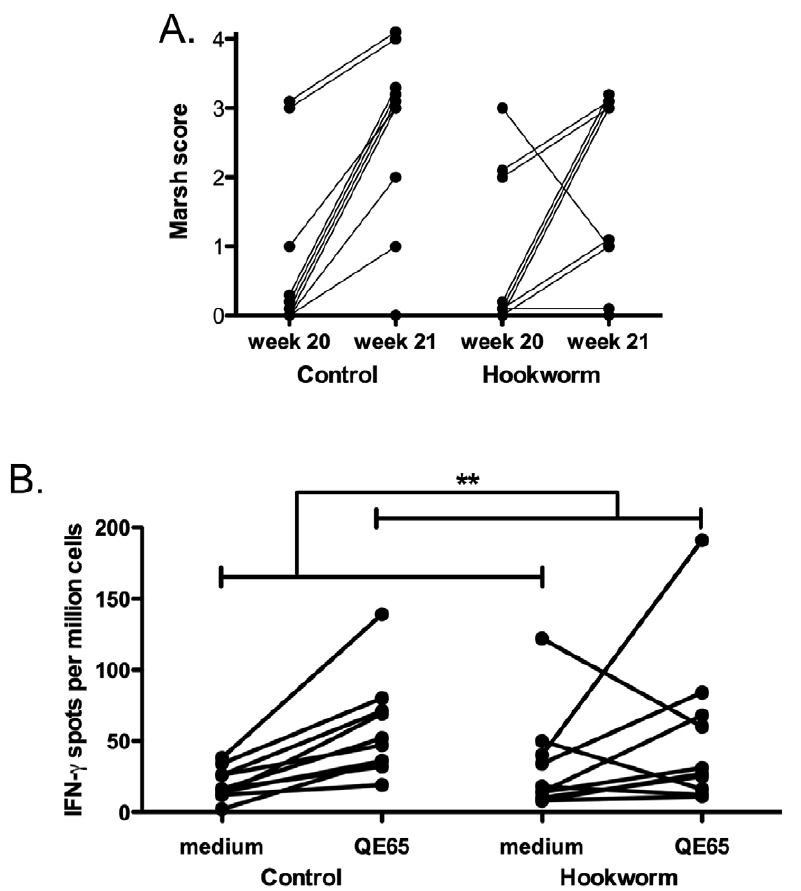
Figure 6. Histological and immunological results. (A) Marsh score and (B) IFN- c ELISpot. Data was analyzed by two-way ANOVA: significant effects of time only were shown as indicated, no significant effect of group or interaction was found in (A) or (B).